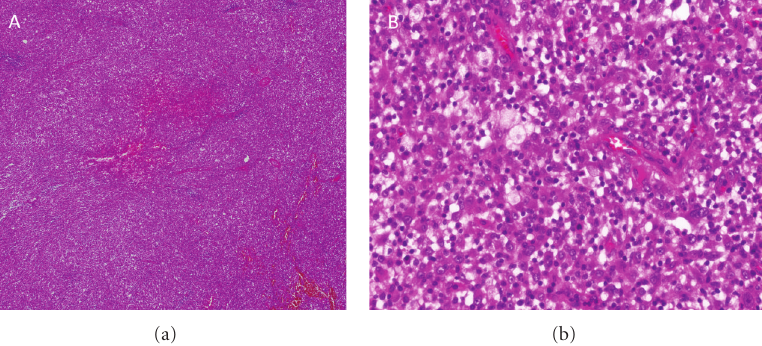
Figure 4: Tumor biopsy showing a dense highly vasculated mixed inflammatory infiltration ((a); H&E, 40x), composed of macrophages with foamy cytoplasm, so called histiocytes, some lymphocytes and plasma cells ((b); H&E,